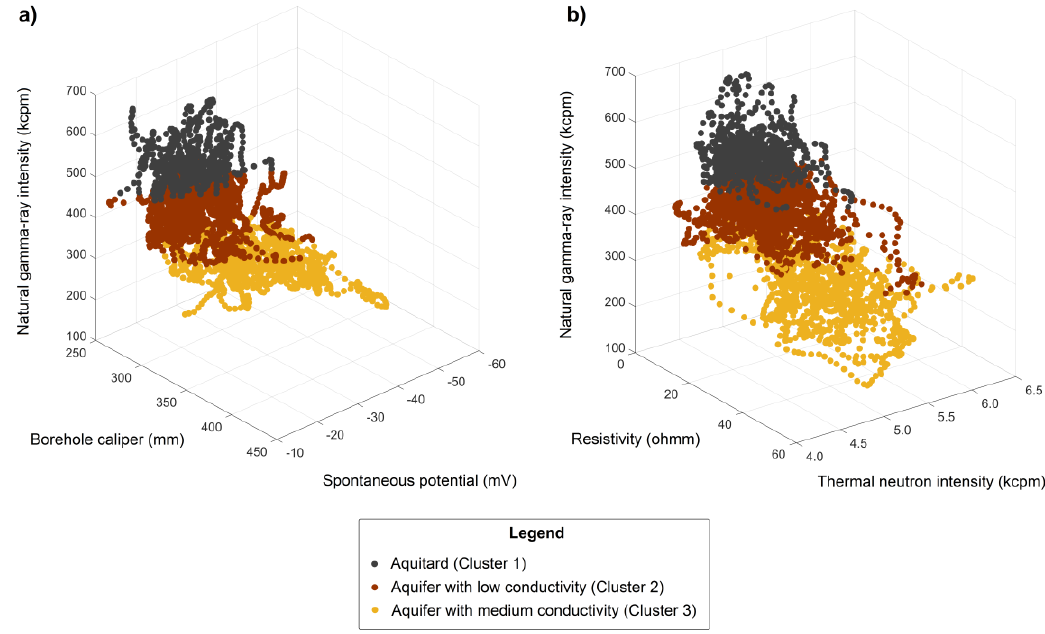
Figure 13. Result of cluster analysis based on the L 1 -norm. The clusters (clusters 1-3) are represented in the data space of in situ measured parameters: ( a ) natural gamma-ray intensity, borehole caliper and spontaneous potential; ( b ) natural gamma-ray intensity, apparent (shallow) resistivity and thermal neutron intensity in Baktalórántháza-1 well.